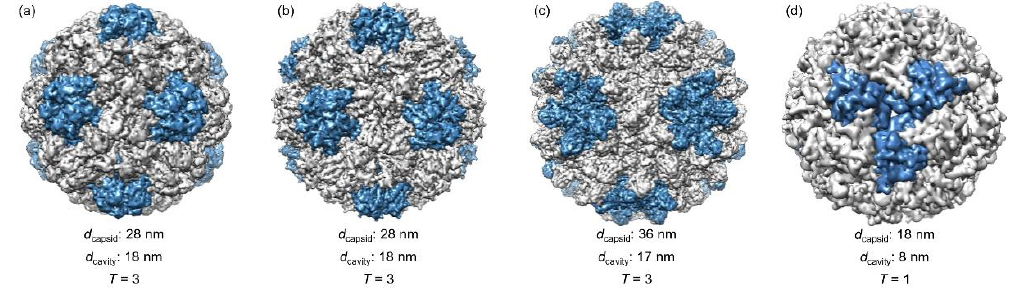
Figure 1. Structures of protein cages highlighted in this review (not drawn to scale, blue color indicates the 12 pentamers and gray color indicates the 20 hexamers in ( a – c )): ( a ) Brome mosaic virus (BMV) (PDB 1JS9). ( b ) Cowpea chlorotic mottle virus (CCMV) (PDB 1CWP). ( c ) Red clover necrotic mosaic virus (RCNMV) (PDB 6MRM) and ( d ) lumazine synthase from Aquifex aeolicus (AaLS) (PDB 1HQK). Blue color indicates three protein subunits.